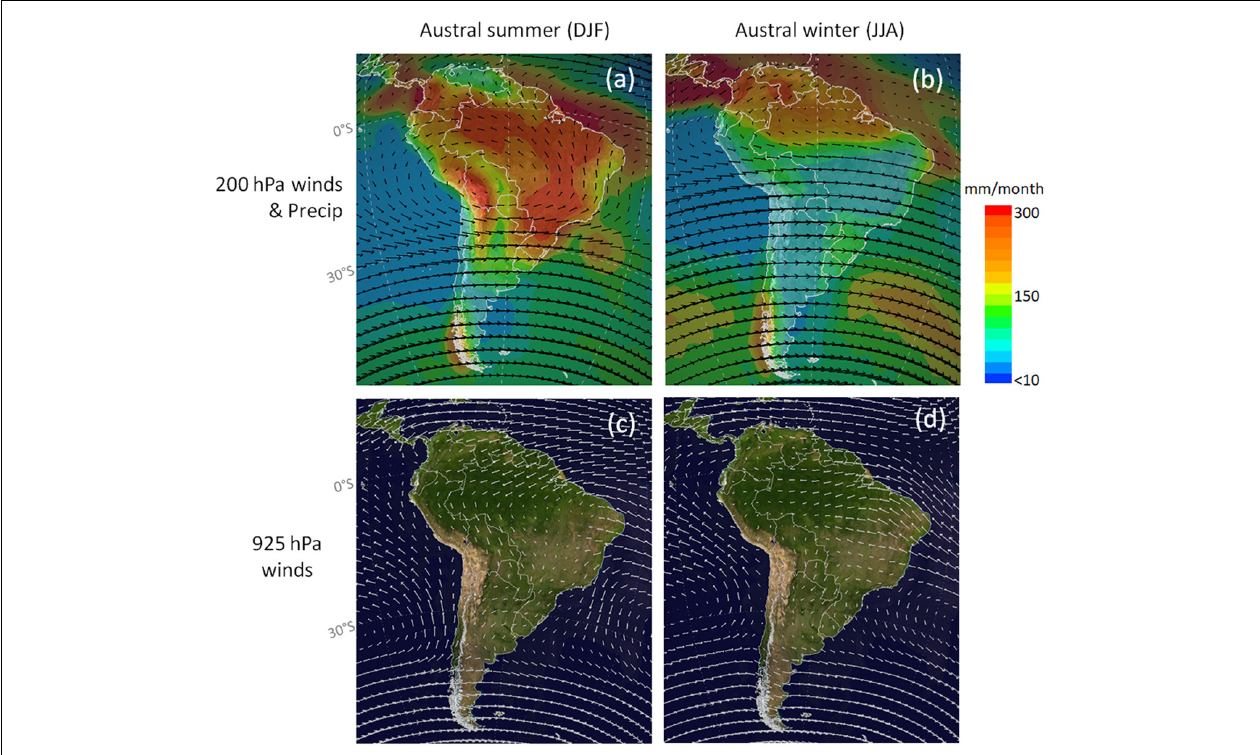
with westerly flow from 25 ◦ S southward and easterly flow at low latitudes. During the austral winter [June-July-August